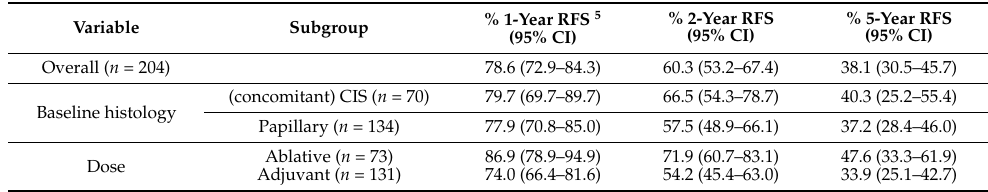
Table 3. Recurrence free survival and durable response